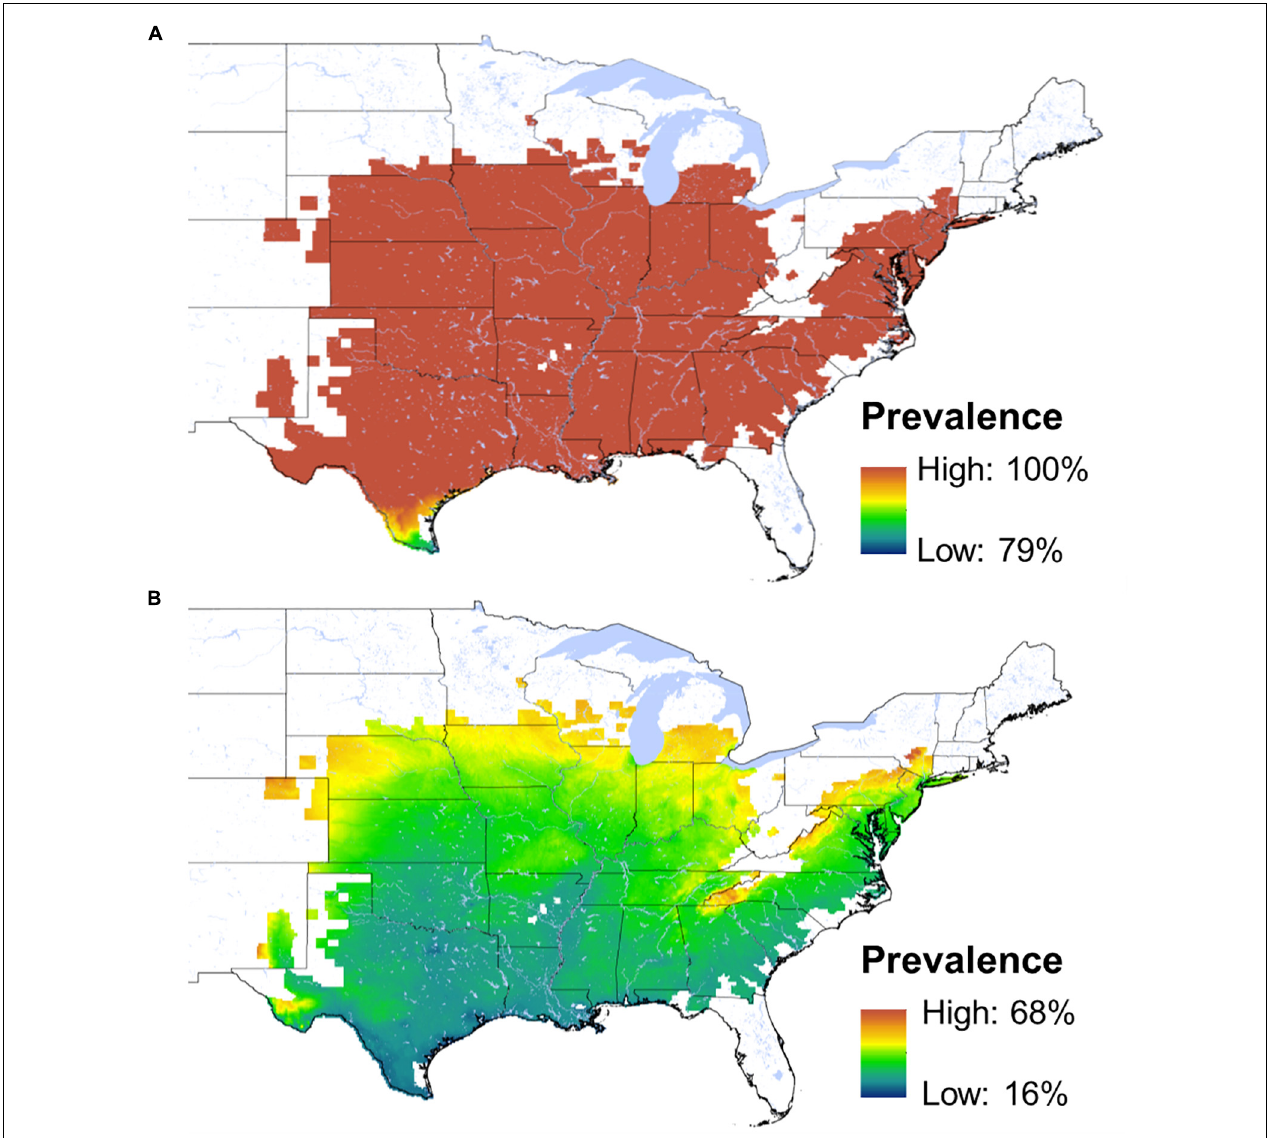
FIGURE 3 | Maps of predicted infection prevalence for A. crepitans frogs exposed to the Bd pathogen. Over nearly all of this host’s range the predicted prevalence is 100% during the coldest active months (A) . Prevalence is predicted to reach its lowest point in July (B) when frog body temperatures are